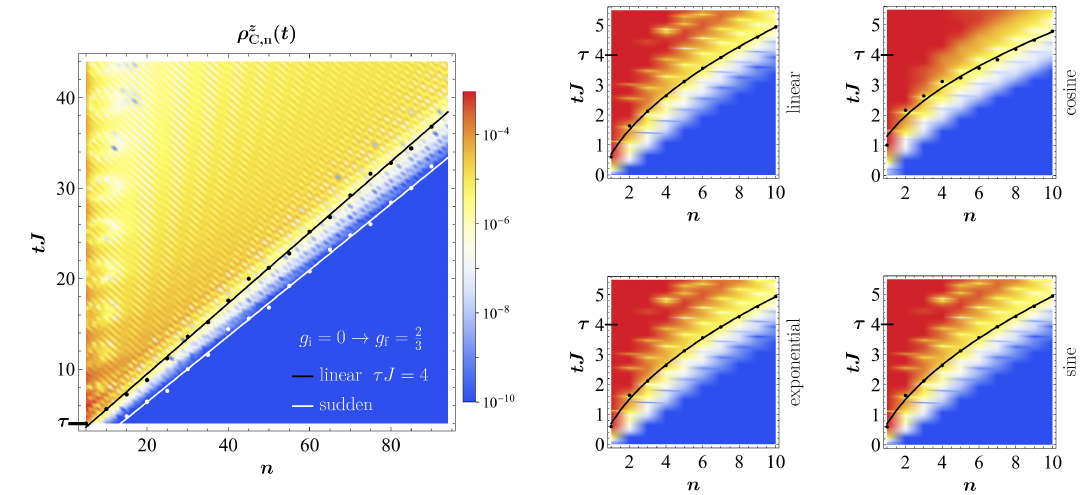
Figure 8: Left: Density plot of the two-point correlation function in the transverse direction following a linear quench. Points of onset are extracted from the first variation with an absolute value not smaller than 1% of the global maximum, lines are linear fits on those points. In white we also indicate the horizon in the sudden-quench case. Right: Density plots of the two-point correlation function in the transverse direction during and after several quench protocols with the same initial and final parameters as on the left. Lines are square root fits on onset